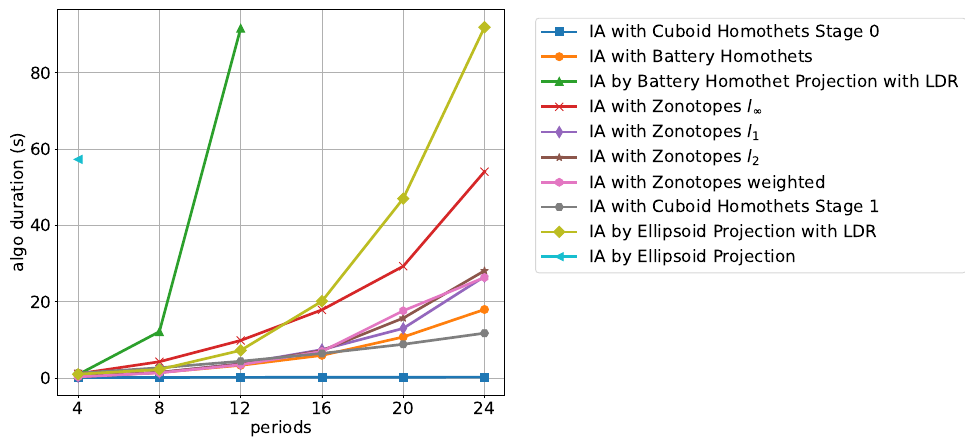
Figure 10. Computation time dependence on the number of periods for 20 households.